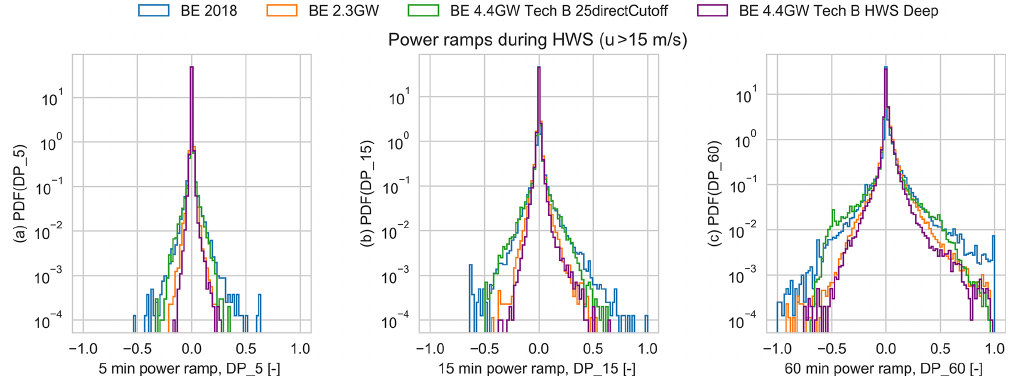
Figure 12. Distributions of standardized power fluctuations during high wind speeds in all the scenarios in different time windows: (a) 5min (DP_5), (b) 15min (DP_15), and (c) 1h